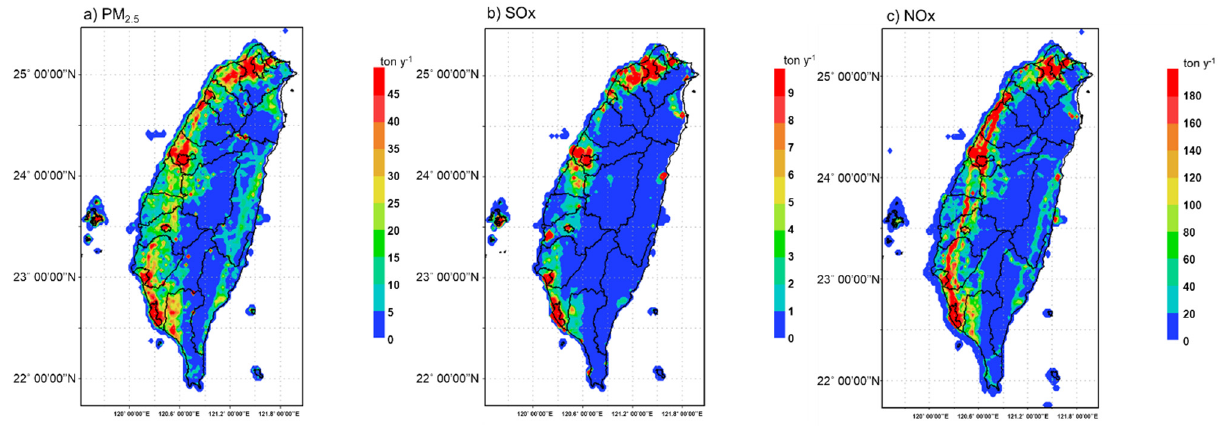
Figure 8 . The emission distribution (ton y − 1 ) of PM 2.5 ( a ), Sox ( b ), and NOx ( c ) for scenario II. Figure 8. The emission distribution (ton y − 1 ) of PM